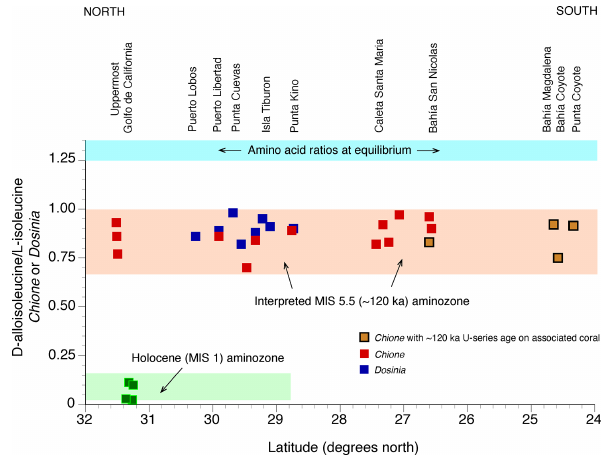
Figure 34. Plot showing ratios of D-alloisoleucine to L-isoleucine in fossil Chione (red squares) and Dosinia (blue squares) as a function of latitude in Baja California, Baja California Sur, and Sonora (localities listed in Table S2). Amino acid data from Or- tlieb (1987, 1991), and Umhoefer et al. (2014). Also shown (solid green squares) are ratios of D-alloisoleucine to L-isoleucine in late Holocene, radiocarbon-dated Chione shells from the upper Golfo de California (data from Martin et al., 1996), and ratios of D- alloisoleucine to L-isoleucine (blue shade) at equilibrium (from Miller and Mangerud, 1985). Pink shade defines aminozone corre- lated to MIS 5e, based on calibration with U-series-dated deposits that also contain Chione shells (gold